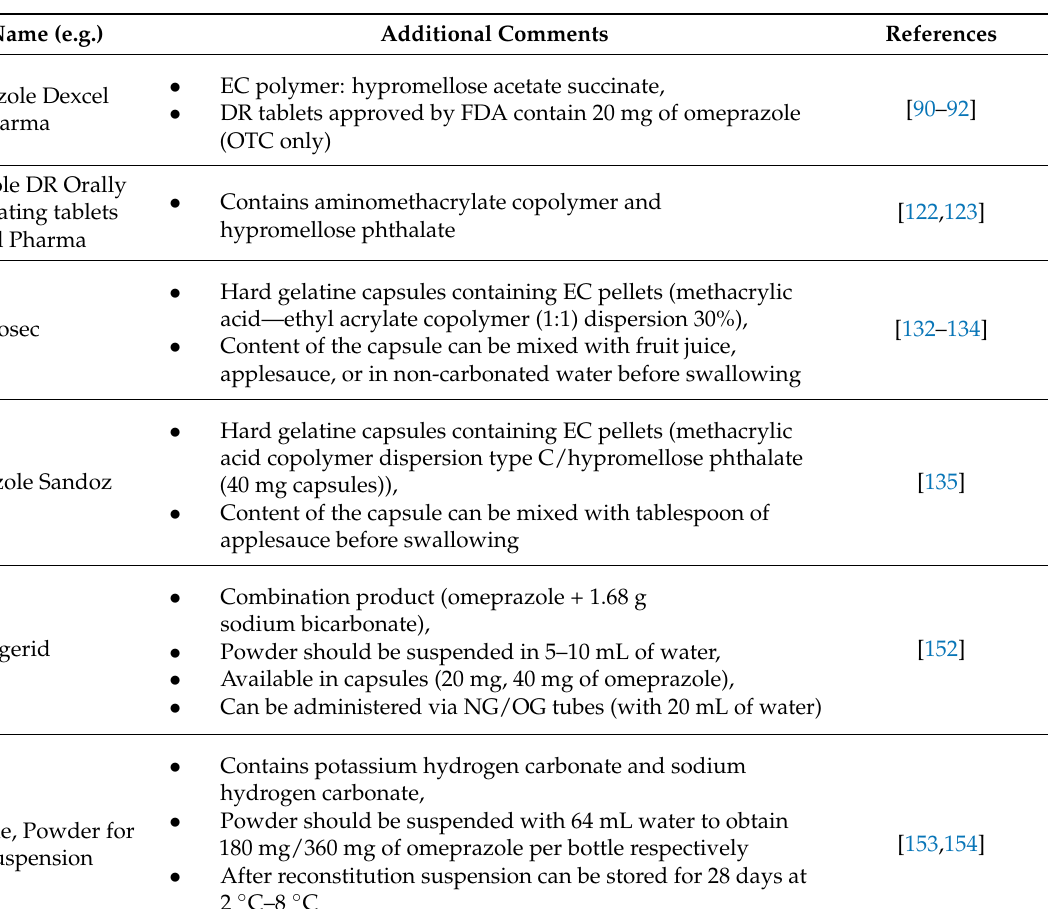
Table 3. Examples of proton pump inhibitors currently marketed in the US and EEA (European Economic Area)/UK